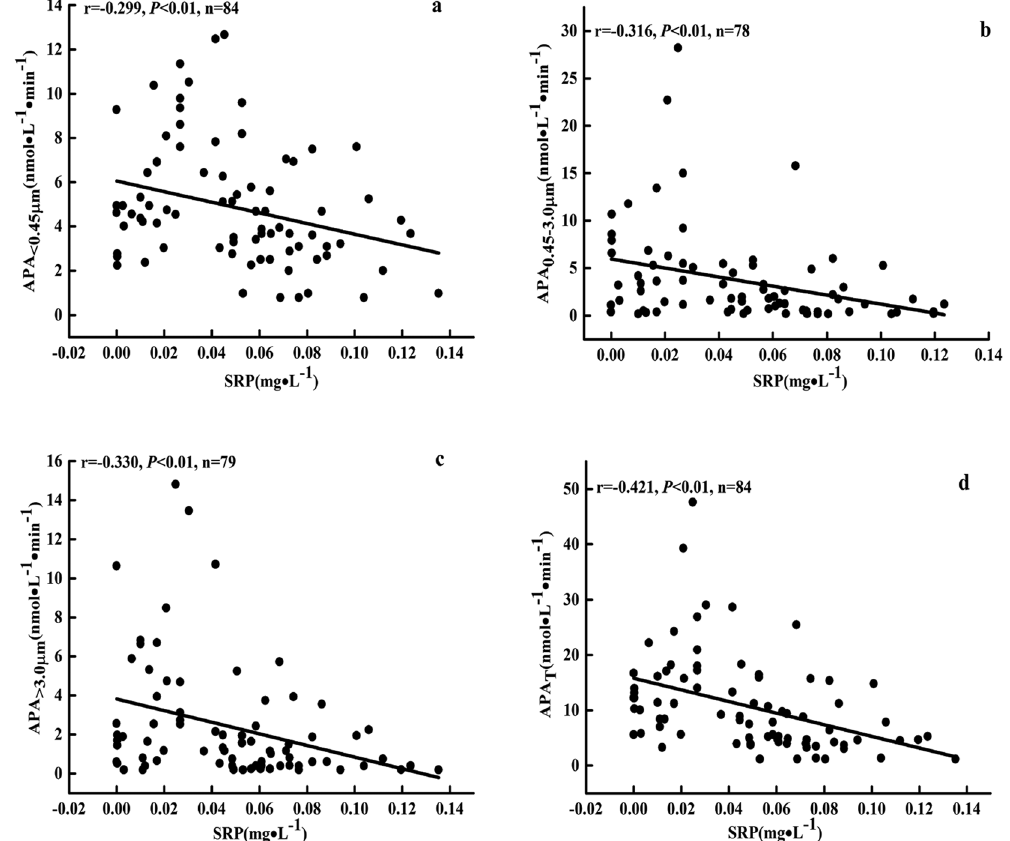
Figure 5. Relationship between soluble reactive phosphorus (SRP) concentrations and APA < 0.45 μ m ( a ), APA 0.45-3 μ m ( b ), APA > 3.0 μ m ( c ) and APA T ( d ) in the Xiaojiang River.